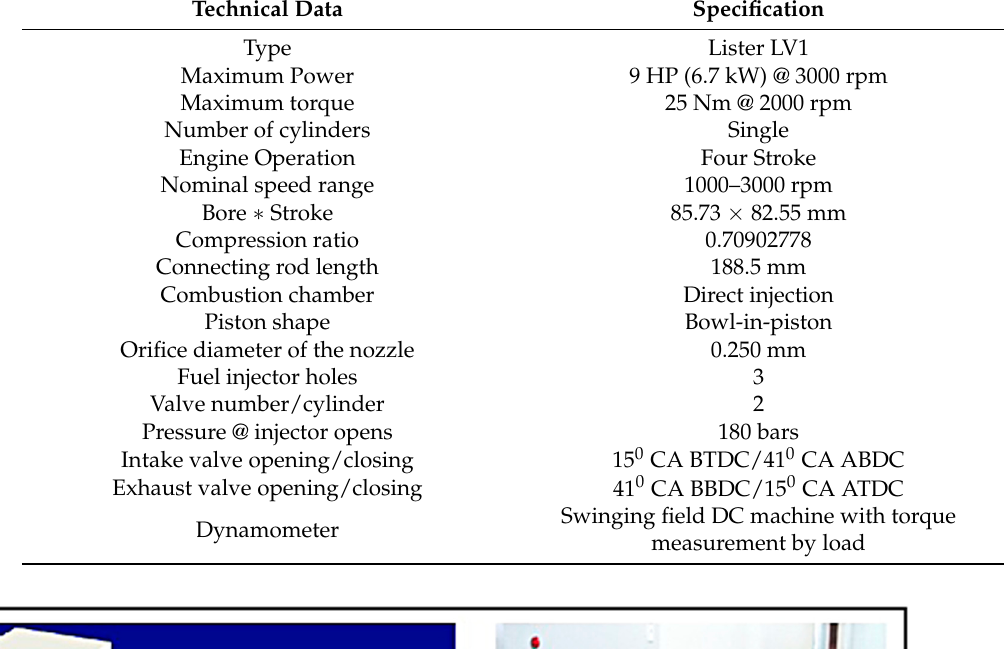
Table 1. Technical data of PETTER PHIW diesel engine.